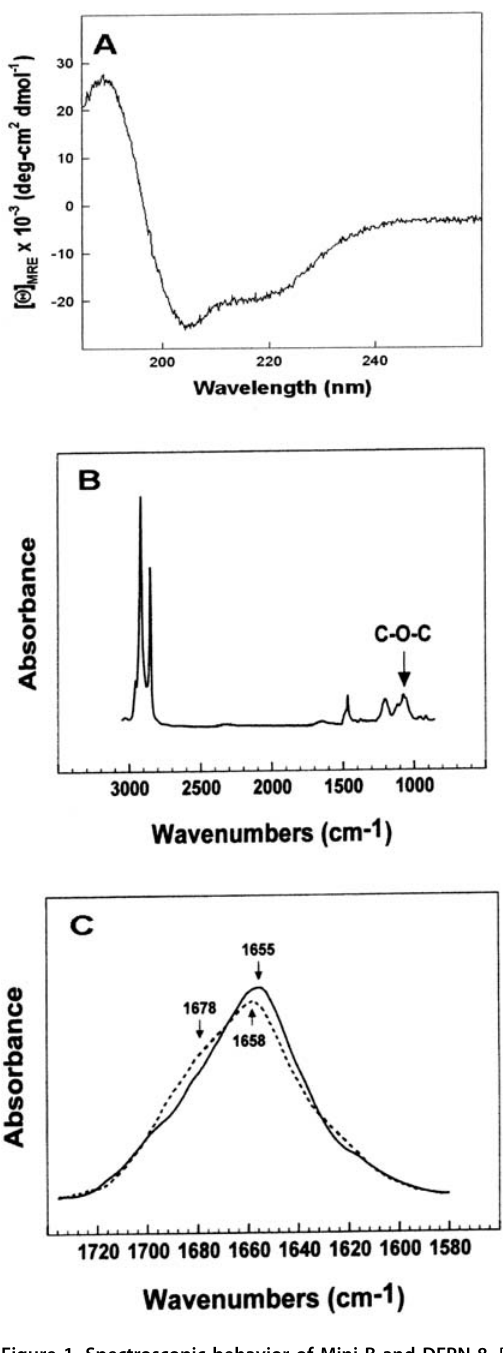
Figure 1. Spectroscopic behavior of Mini-B and DEPN-8. Panel A: CD spectrum for Mini-B in trifluoroethanol (TFE); Panel B: FTIR spectrum for DEPN-8; Panel C: FTIR spectral differences for Mini-B in DEPN-8 (dashed line) compared to Mini-B in TFE (solid line). In Panel A, mean residue ellipticity (MRE) averaged over eight scans is plotted against wavelength for Mini-B in 4:6 (v:v) TFE:10 mM phosphate buffer, pH 7.4. The double minimum at , 208 and 222 nm is indicative of a high a - helical content. In Panel B, the spectrum for DEPN-8 multilayers (100 m g lipid, arbitrary absorbance units) has a ‘‘C-O-C’’ ether linkage-associated absorption band centered at a wavenumber of 1072 cm 2 1 . In Panel C, the IR spectrum of Mini-B in TFE (solid line) has a peak at 1655 cm 2 1 indicating high a -helix levels, while the peak at 1658 cm 2 1 and high- field shoulder at 1678 cm 2 1 for Mini-B in DEPN-8 (dashed line) indicates an increase in turn/bend conformation with a decreased but still prominent a -helix content. See text for discussion. doi:10.1371/journal.pone.0001039.g001 PLoS ONE |